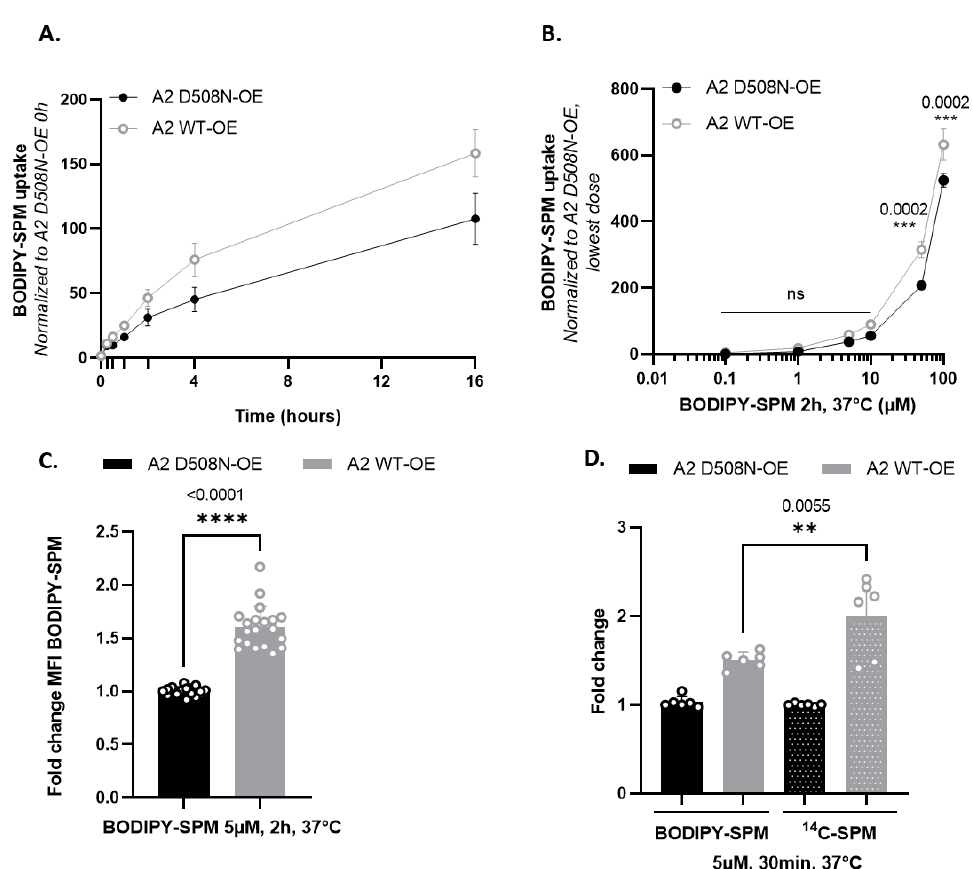
Figure 2. Time- and dose-dependency of BODIPY-SPM uptake in ATP13A2-expressing SH-SY5Y cell models. ( A , B ). SH-SY5Y cells were incubated with 5 µ M BODIPY-SPM for the indicated times (( A ), time dependency) or with increasing concentrations of BODIPY-SPM for 2 h (( B ), dose dependency). The mean fluorescence intensity (MFI) of 10,000 events was recorded using a BD Canto II HTS flow cytometer. Graphs represent the MFI recorded in ATP13A2 WT OE (A2 WT-OE) and ATP13A2 D508N-OE (A2 D508N-OE) cells, normalized to the 0 h incubation time in A2 D508N-OE cells (in A ) or to the lowest concentration of BODIPY-SPM (i.e., 100 µM) in A2 D508N-OE cells (in B ; ns: not significant, **: p < 0.01; ***: p < 0.001; ****: p < 0.0001). ( C ) . Graph depicts the fold change in BODIPY-SPM uptake (5 µM; 2 h) between A2 WT-OE and A2 D508N-OE cells (N = 10, technical duplicates, unpaired t-test). ( D ) . Comparison of the uptake of 5µM BODIPY-conjugated (BDP-SPM) versus 5 µM radiolabeled spermine ( 14 C-SPM) in SH-SY5Y A2 WT-OE and D508N-OE cells for 30 min (N = 3, technical duplicates, one- way ANOVA with Tukey’s multiple comparisons test).